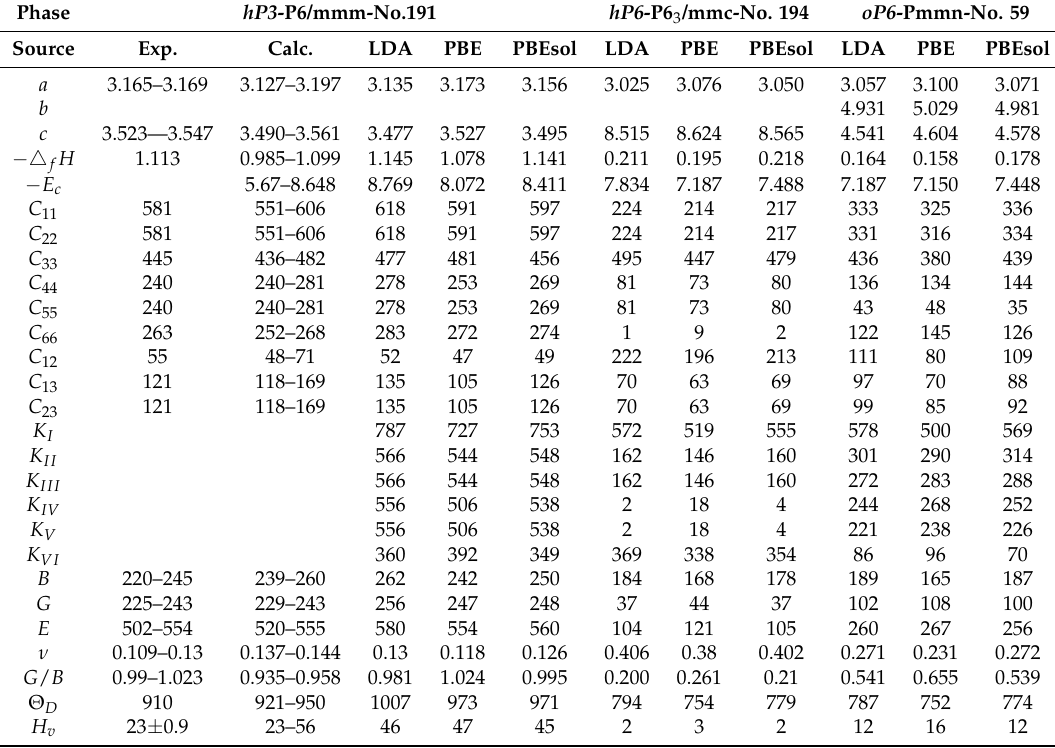
Table 1. Lattice parameters(Å); formation enthalpy (cid:52) f H (eV/Atom); cohesive energy E c (eV/Atom); elastic constants C ij (GPa); Kelvin moduli K i (GPa); bulk modulus B (GPa); shear modulus G (GPa); Young’s modulus E (GPa); Poisson’s ratio ν ; G / B Pugh’s modulus ratio; Debye temperature Θ D (K); hardness H v (GPa), of ZrB 2 phases: ZrB 2 ( hP3 -P6/mmm-space group, no. 191; hP6 -P6 3